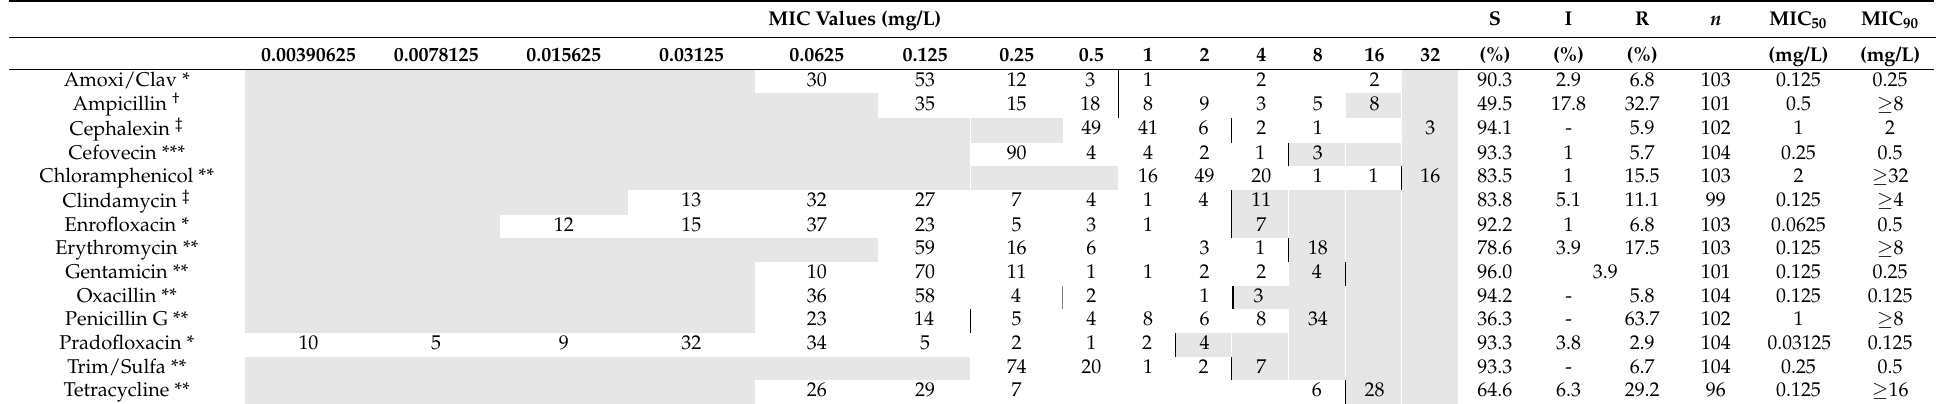
Table 5. Activity of various antimicrobials against coagulase-positive staphylococci (CoPS) isolates cultured from dogs with urinary tract